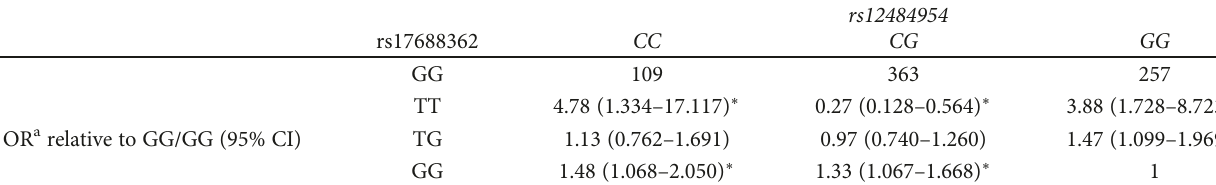
( RNA5SP455 )/keratin 8 pseudogene 5 ( KRT8P5 ) and the gene dynein axonemal light chain 4 ( DNAL4 ). The two SNPs are relatively common (MAFs of 0.21 and 0.39, resp.). Over- all, the odds of hypertension were increased by carrying minor alleles, except for the genotype TT/CG which had a lower odds ratio (Table 2(d), OR =0.27; 95% CI: 0.128